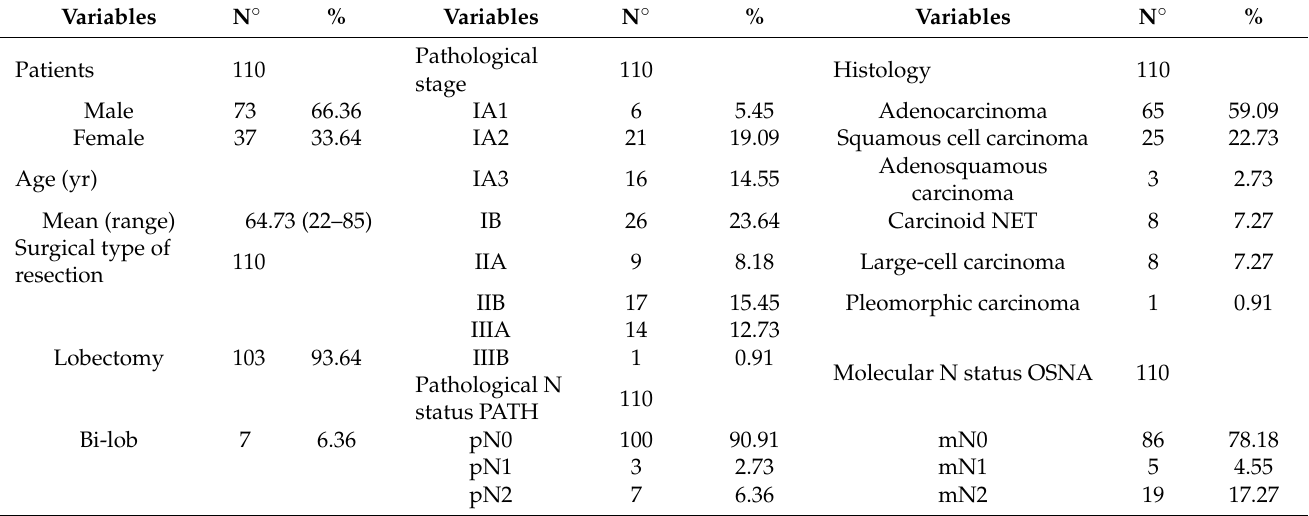
Table 1. Baseline characteristics of the patients included in the follow-up study.